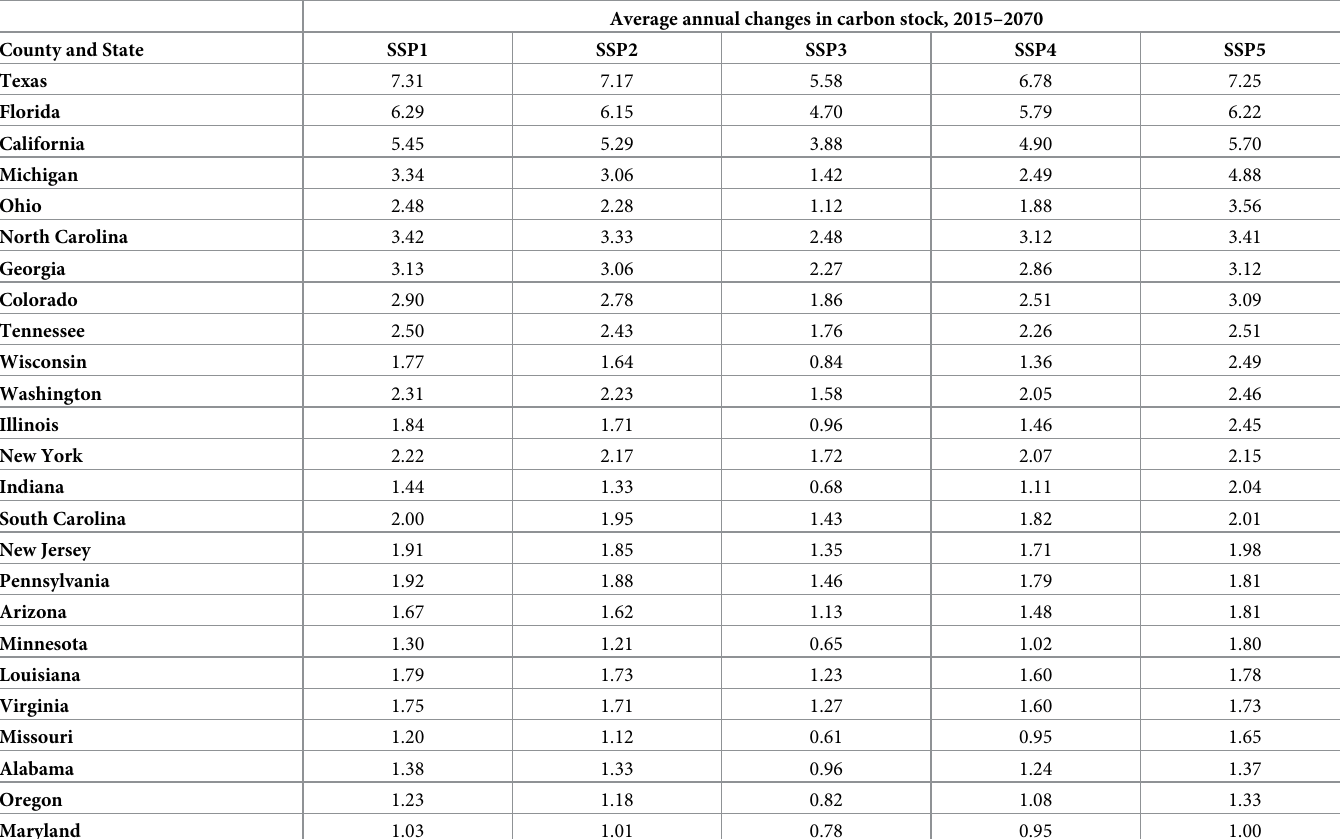
Table 5. Top 25 states with the projected largest contributions to US residential housing sector carbon sink (thousand t CO 2 e per year), 2015–2070, sorted by Shared Socioeconomic Pathway